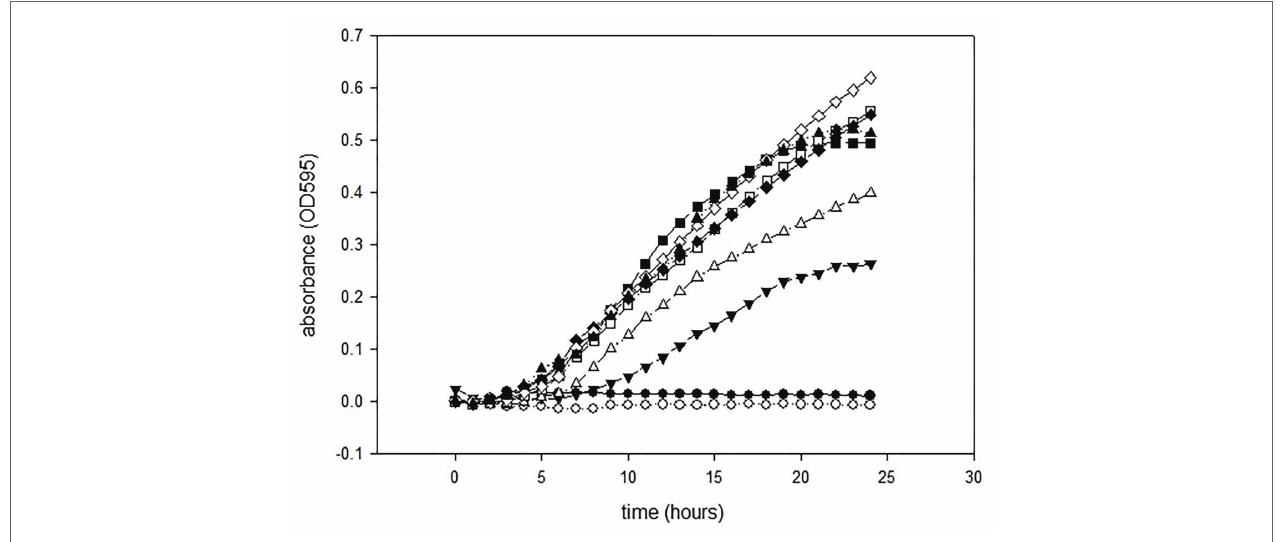
FIGURE 3 | Minimum inhibitory concentrations of GCEO against Pseudomona aeruginosa ATCC 14213. GCEO used at 2% ( ● ), 1% ( ○ ), 0.5% ( ▼ ), 0.25% ( ∆ ), 0.0125% ( ■ ), 0.063% ( □ ), 0.031% ( ♦ ), 0.015% (◊), and positive control ( ▲ ).